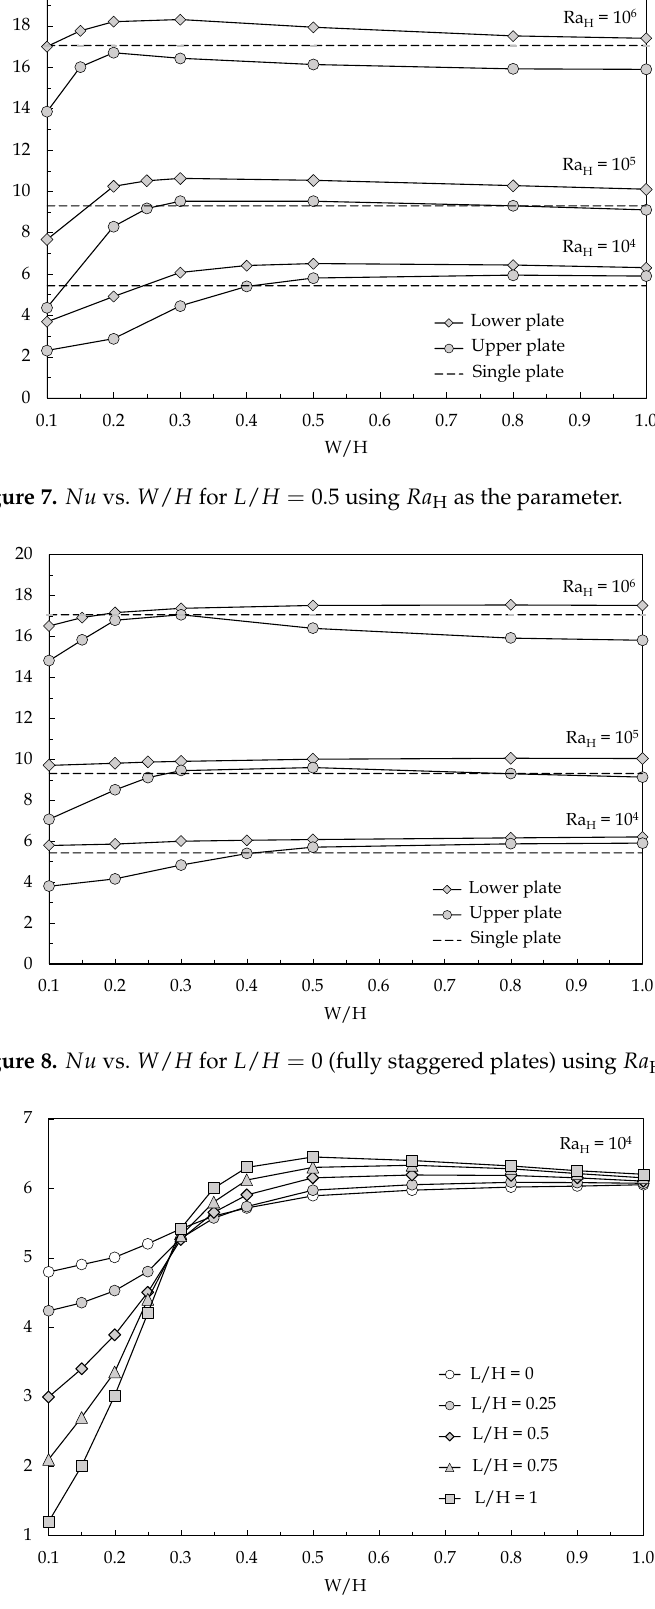
Figure 9. Nu vs. W / H for Ra H = 10 4 using L / H as the